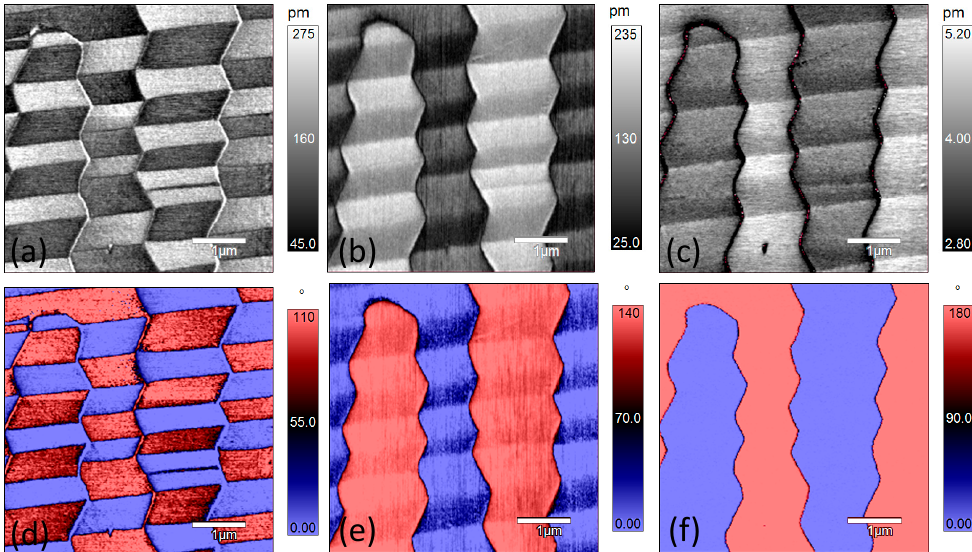
Figure 4. PFM amplitude and phase images of (001)-cut PZN-7%PT single crystal at 50 °C: ( a – c ) amplitude images of x-LPFM, y-LPFM, and VPFM, respectively; and ( d – f ) phase images of x- LPFM, y-LPFM, and VPFM, respectively as in Figure 2 at 75 °C. The width of the stripes in the x- LPFM amplitude (Figure 5a) and phase (Figure 5d) images become narrower than those at room temperature and 50 °C, and the number of domain walls increases. This is an indication of polari- zation rotation or phase transition with increasing temperature because the increase of domain wall area and the formation of sub-domains can help absorb the strain generated during the polar- ization rotation or phase transition process [35]. Additionally, the stripe-featured contrast in the y- LPFM amplitude image (Figure 5b) becomes ambiguous and the phase angle difference (Figure 5e) continues to decrease. Another change is that the y-LPFM and VPFM phase contrasts in the circled regions in Figure 5b,c,e,f became opposite to those at lower temperatures. This may be owing to the stability loss of the compensational surface charge at the top end of the domain at high temper- atures [36,37]. The sample further was heated to 100 °C, and the PFM amplitude and phase did not show any significant change (Figure S1).